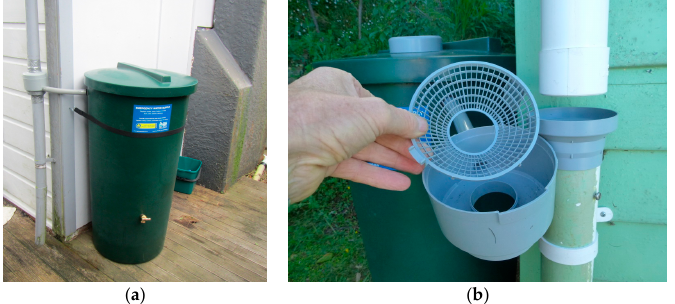
Figure 2. ( a ) WREMO emergency 200-L rainwater tank installed at Site 6; and ( b ) detail of diverter showing coarse screen (photo credit: Jim Cousins).